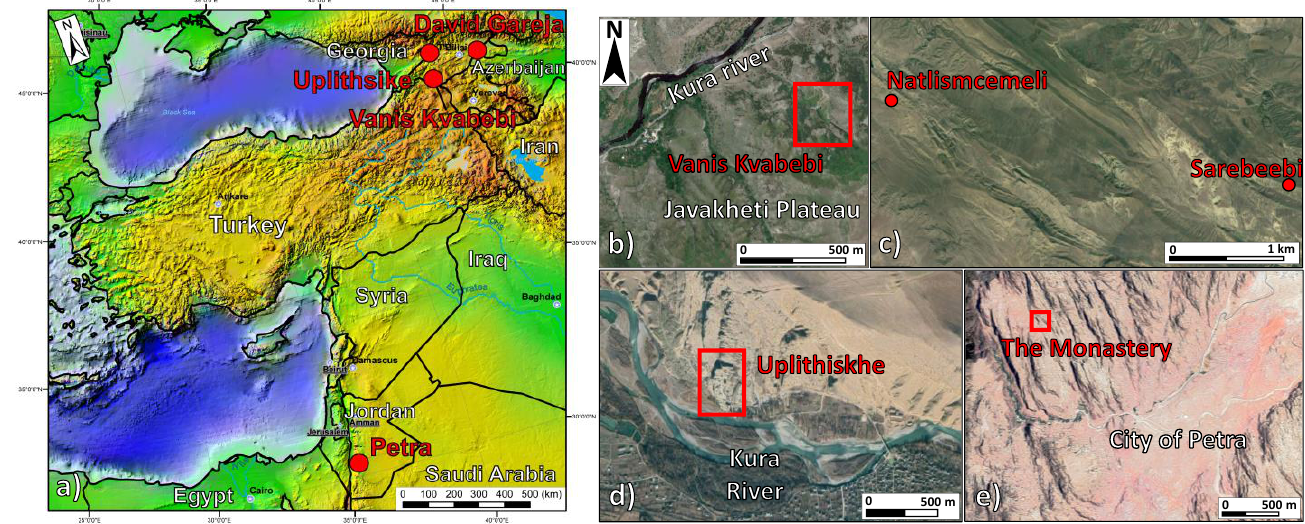
Figure 1. Map with the location of the analyzed rock-carved cultural heritage sites ( a ); locations at a higher scale: Vanis Kvabebi ( b ); David Gareja area ( c ); Uplistsikhe ( d ); The Monastery of Petra ( e ).